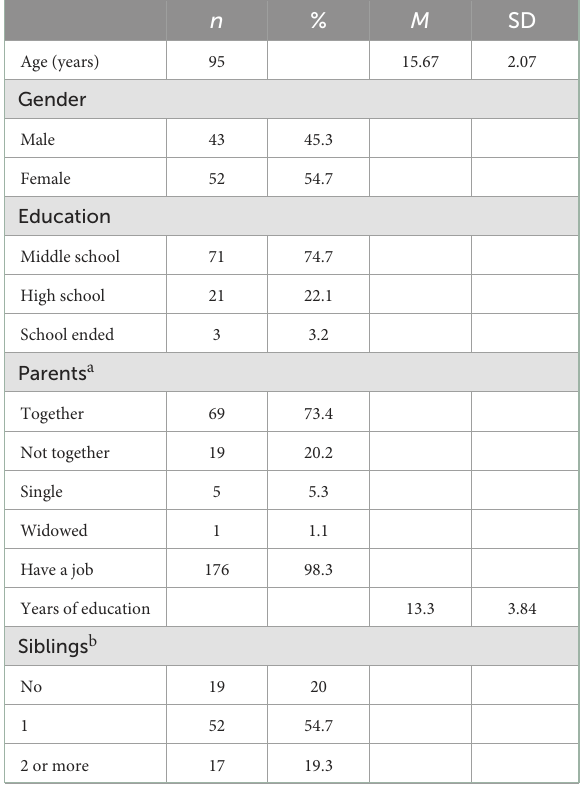
TABLE 1 Sociodemographic characteristics of 95 community